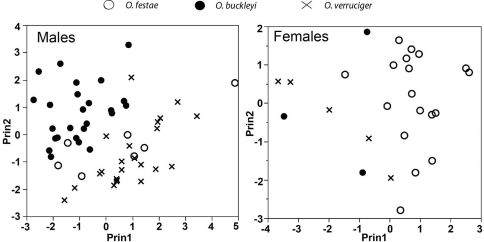
Principal components from analysis of seven size-corrected morphological variables. See Table 5 for character loadings on each component.